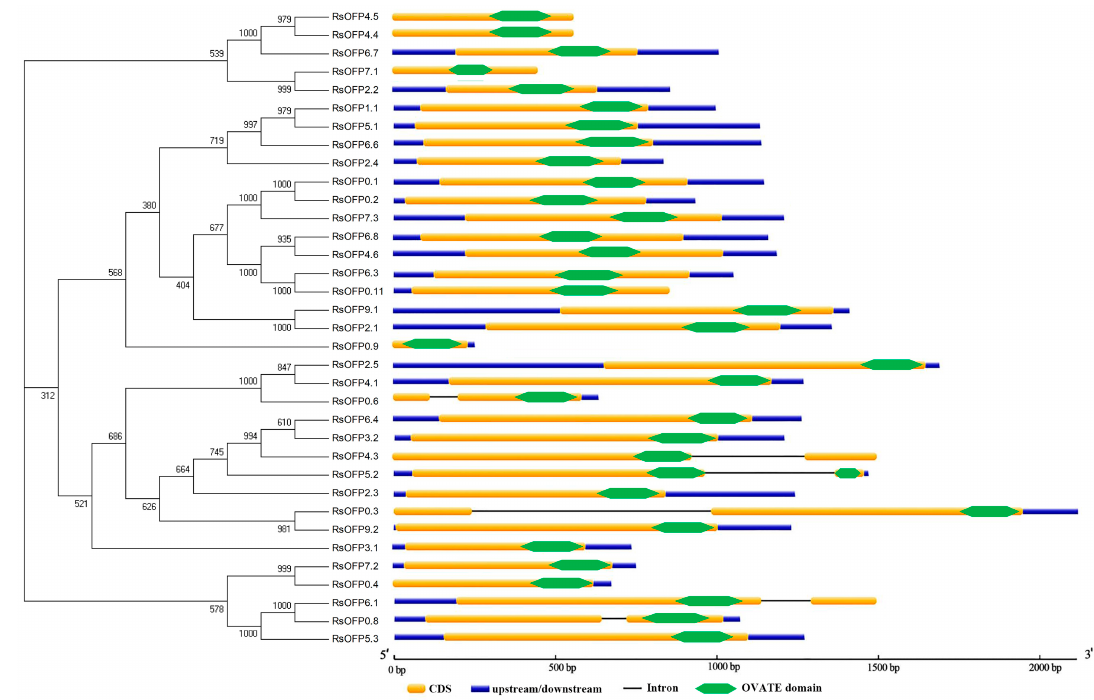
Figure 1. Phylogenetic analysis and genomic structures of RsOFPs . The phylogenetic tree displays only the topology. Yellow bars represent coding region sequences (CDS), dark blue bars represent upstream / downstream sequences, black lines represent introns, and diamond bars represent the OVATE domain.